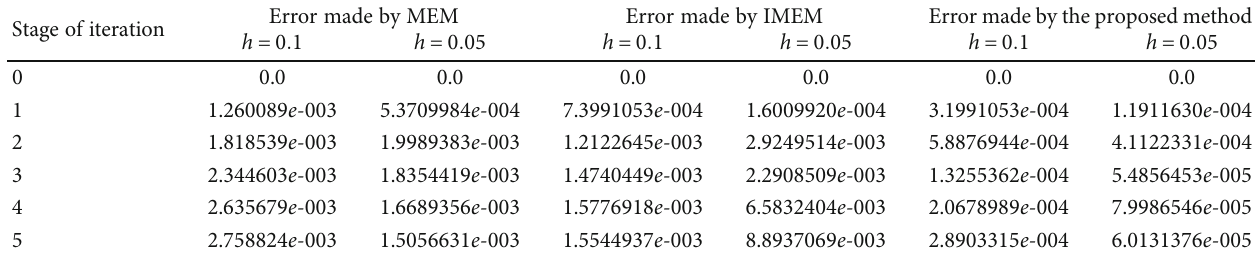
Table 2: Absolute errors made for Example 1.